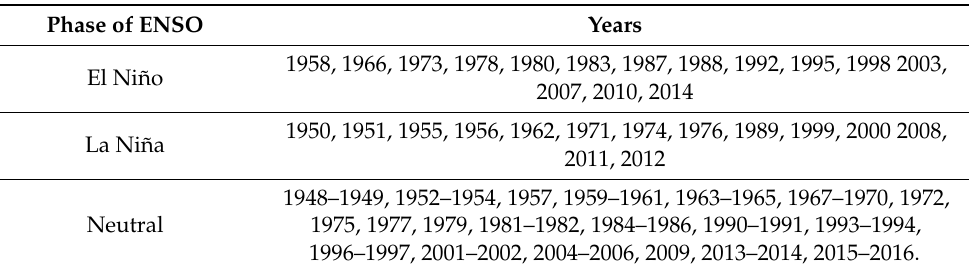
Table 1. Identified years under the phase of